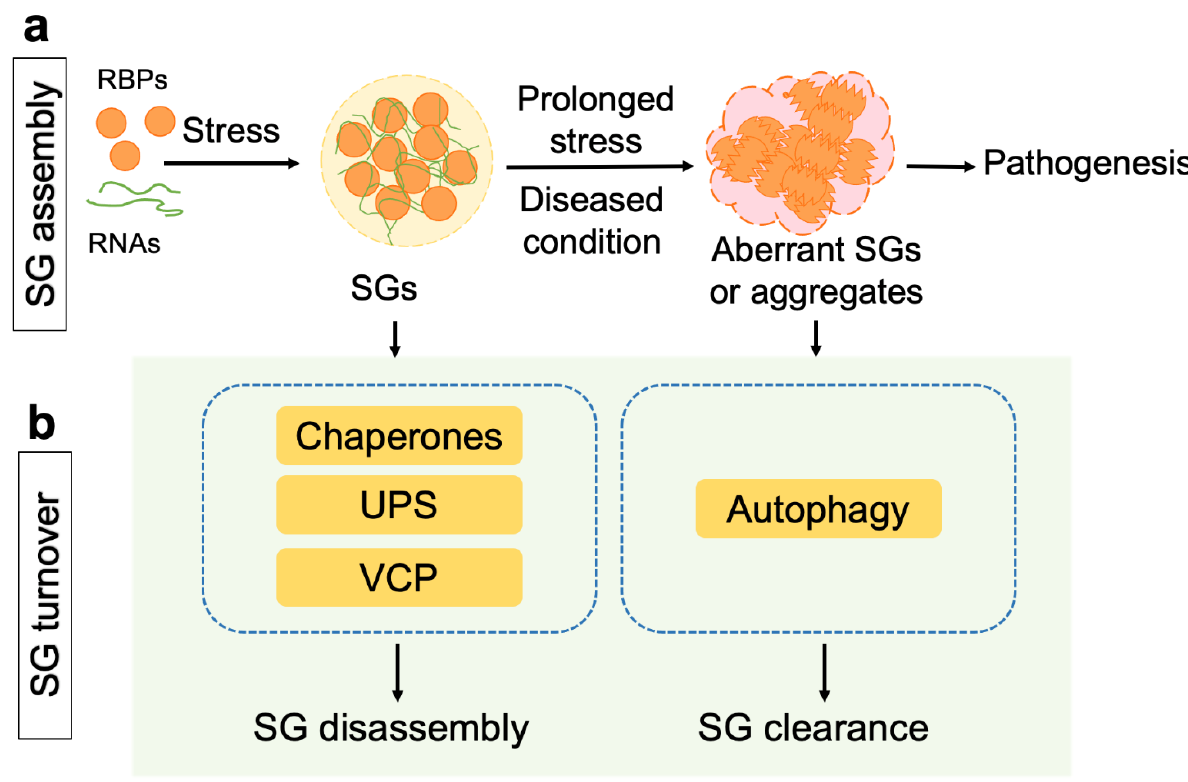
Figure 1. A schematic of the formation and turnover of SGs. ( a ) Cellular stress induces the assembly of SGs containing RBPs and RNAs. Under diseased conditions such as in prolonged stress or induced by pathogenic mutations, aberrant SGs and/or protein aggregation are formed in cells. ( b ) Upon removal of stress, dynamic SGs are promptly disassembled by molecular chaperones, the UPS and VCP, whereas aberrant SGs and solid protein aggregates are cleared via the autophagy pathway. Abbreviations: RBPs, RNA-binding proteins; SGs, stress granules; UPS, ubiquitin-proteasome system; VCP, valosin-containing protein.